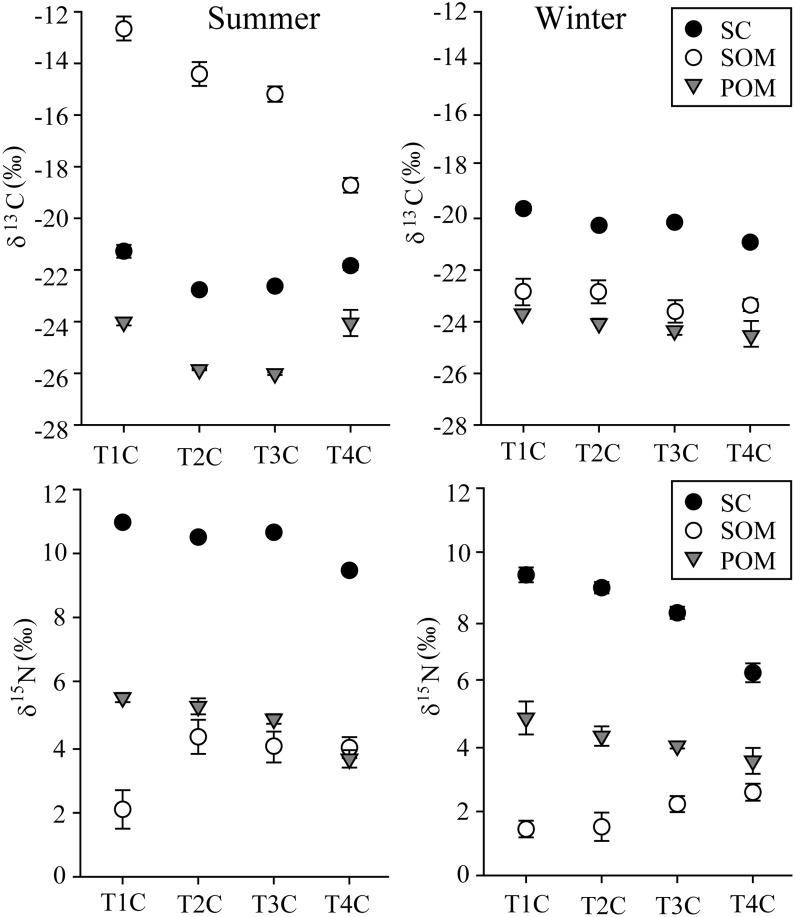
δ13C and δ15N of Sinonovacula constricta and SOM, POM from creek center sites of 4 transects in summer and winter.